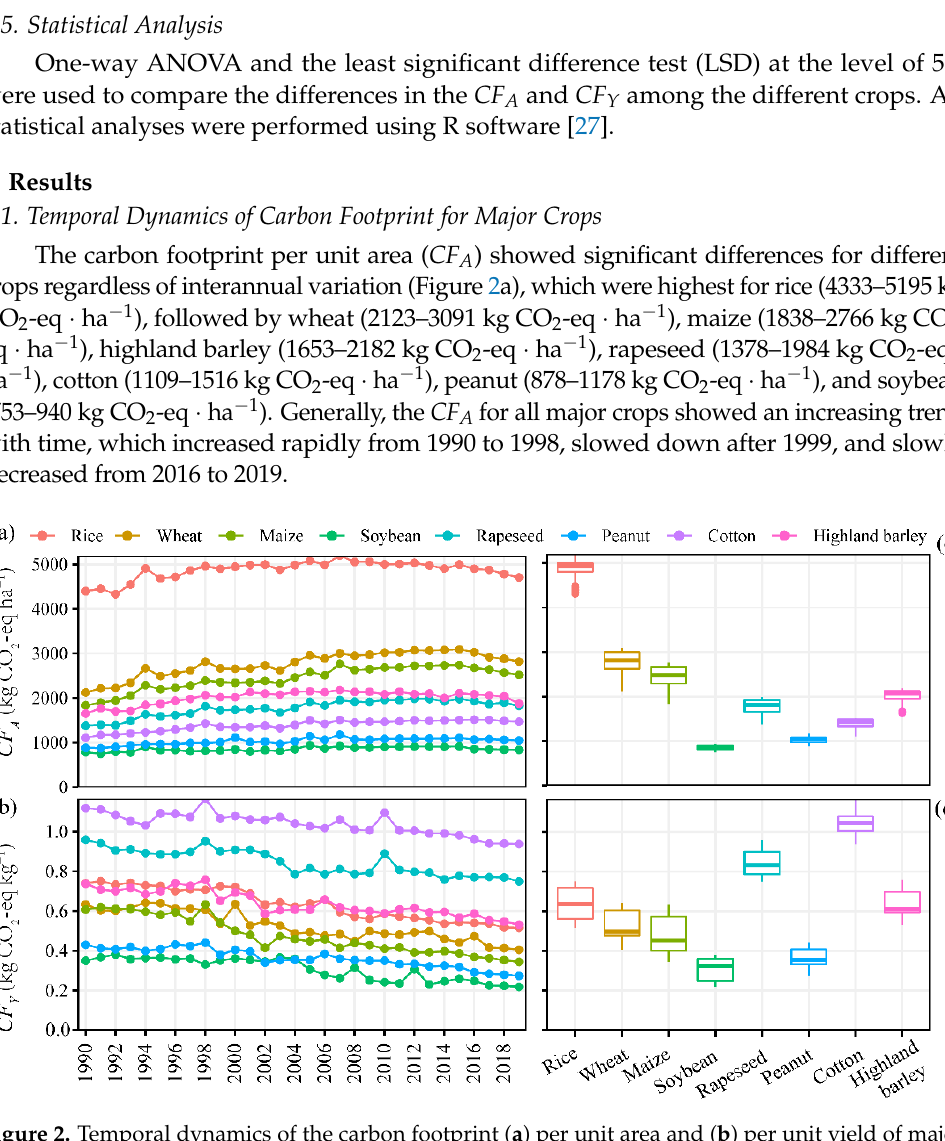
Figure 2. Temporal dynamics of the carbon footprint ( a ) per unit area and ( b ) per unit yield of major crops in China from 1990 to 2019, and the averaged carbon footprint ( c ) per unit area and ( d ) per unit yield of major crops in China.